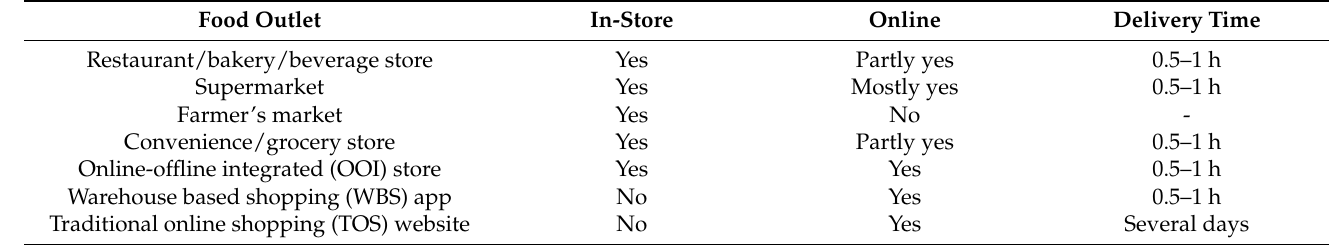
Table 1. Food outlet types in the community food environment of Chinese